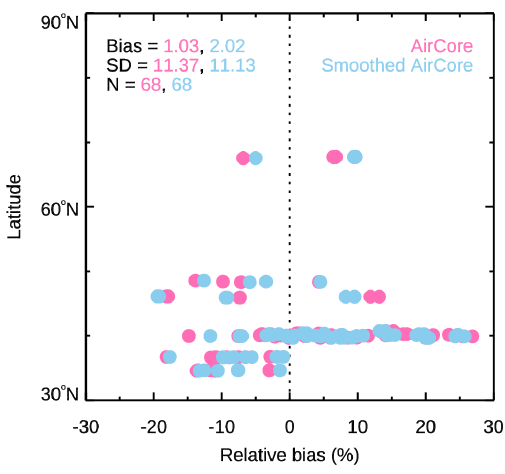
Figure 6. Latitudinal distribution of bias values between TROPOMI and AirCore cloudy observations over